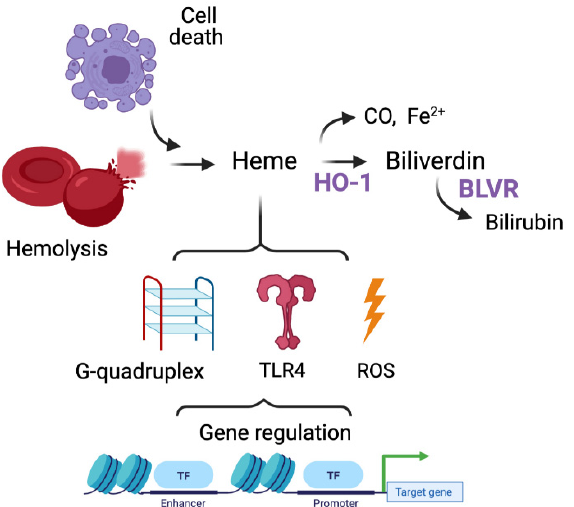
Figure 1. A model explaining the role of heme metabolism in the regulation of heme levels and cancer growth. Labile heme released from dying cells and/or erythrocytes (hemolysis) regulates gene expression via G4 DNA binding, ROS generation and TLR4 binding. BLVR- biliverdin reduc- tase.